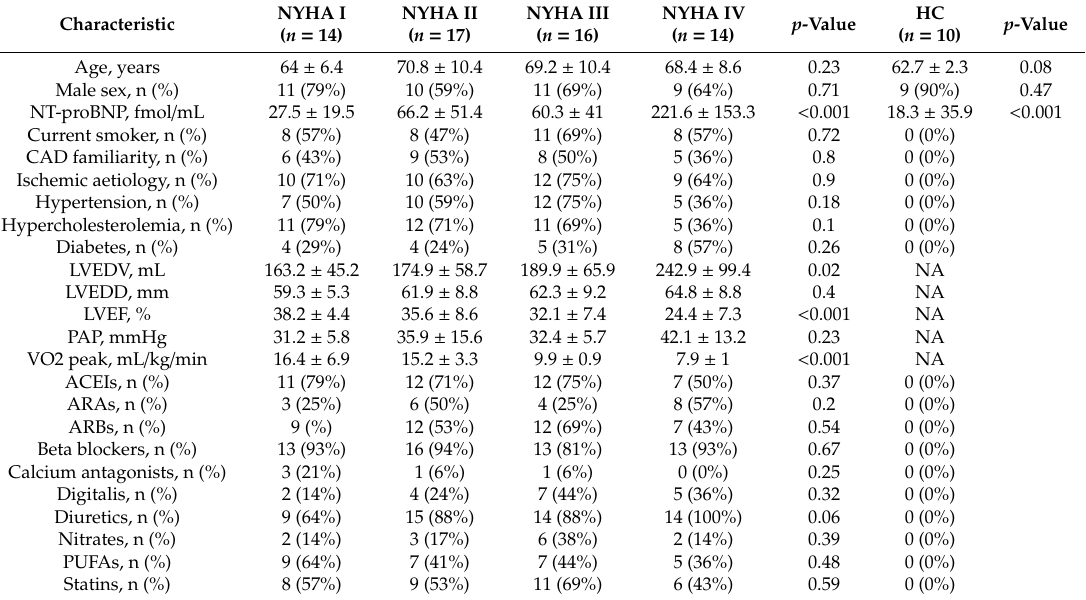
Table 1. Demographic and clinical features of the study population.